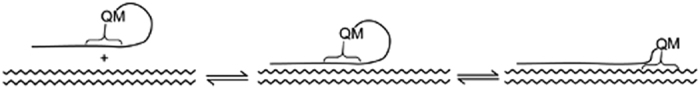
Possible equilibria controlling target-specific alkylation. QM represents a quinone methide adduct formed with the DNA.